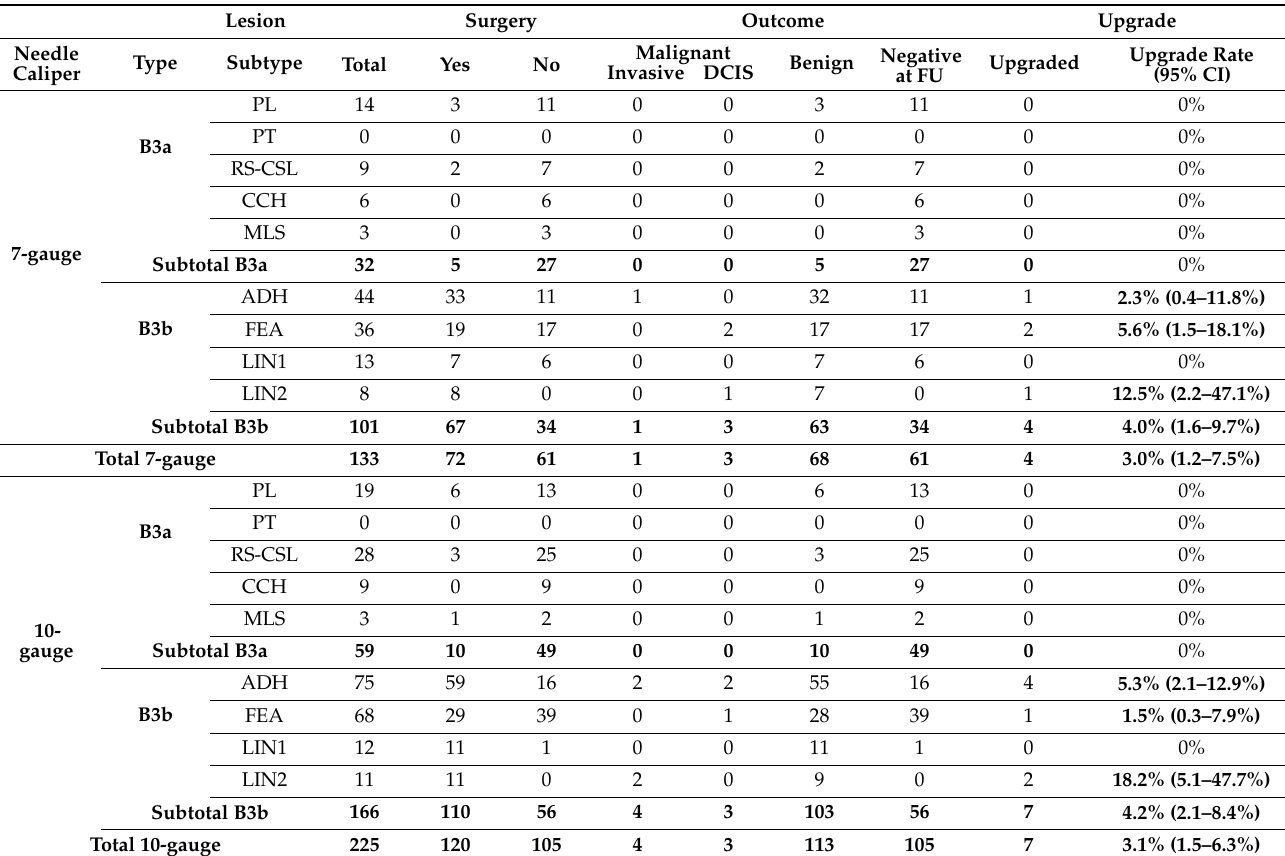
Table 4. Needle caliper subgroups for the 358 B3 lesions that underwent stereotactic-guided vacuum-assisted biopsy.